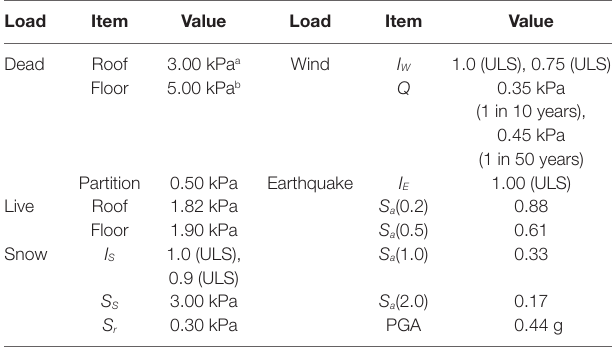
TaBle 1 | Structural design data for North